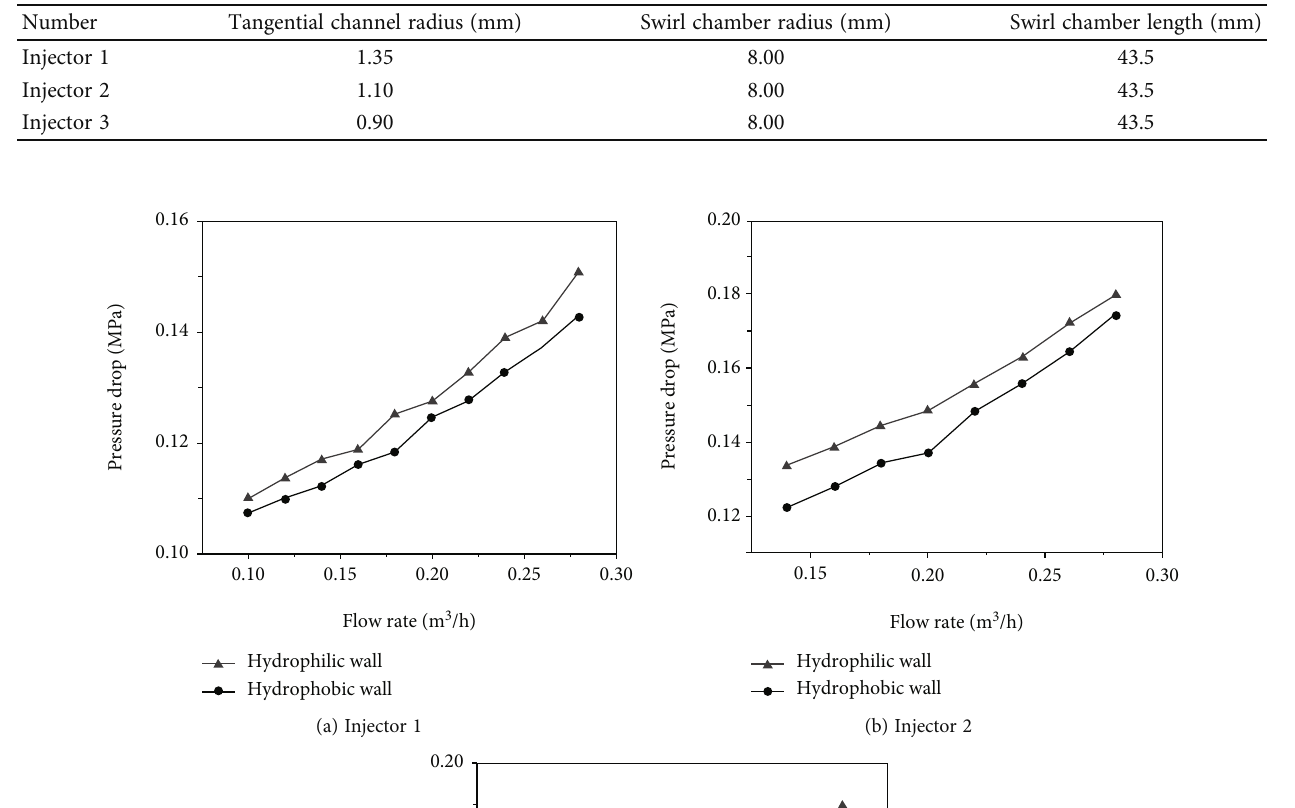
Table 2: Injector structure parameters.